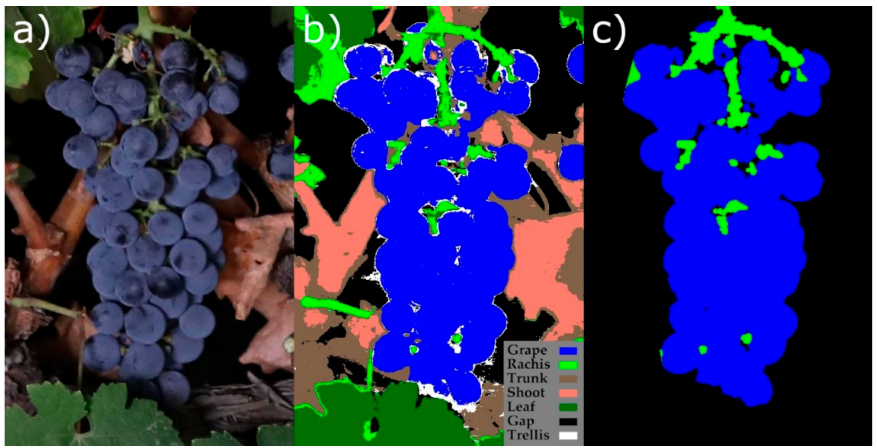
Figure 6. Extraction of the clusters’ final masks for compactness estimation. ( a ) Extracted cluster sub-image, ( b ) its corresponding segmentation, and ( c ) a cluster mask obtained using “grape” and “rachis” pixels and morphological